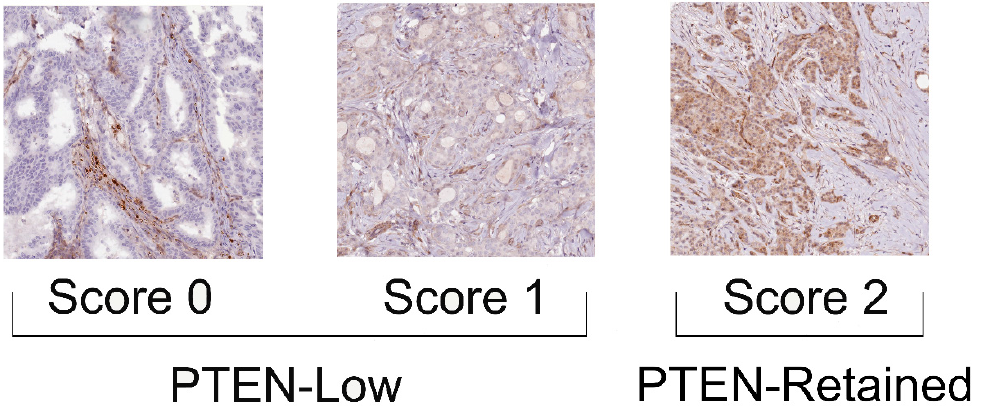
Figure 5. Patterns of PTEN expression and scoring system employed in the present study. Score 0 was assigned in the absence of immunohistochemical staining in the tumor cells; score 1 was assigned when the neoplastic cells showed a weaker staining than the normal counterpart; score 2 was assigned in cases with equal staining intensity between tumor and normal epithelial/stromal cells; Cases were clustered as PTEN-low (score 1 and score 0) and PTEN-retained (score 2). Original magnification: 100×.